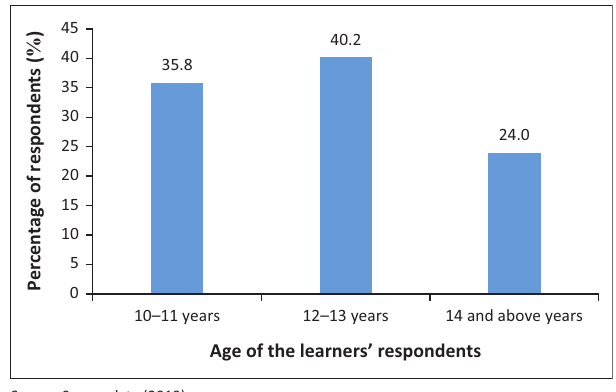
FIGURE 1: Age distribution of the respondents.